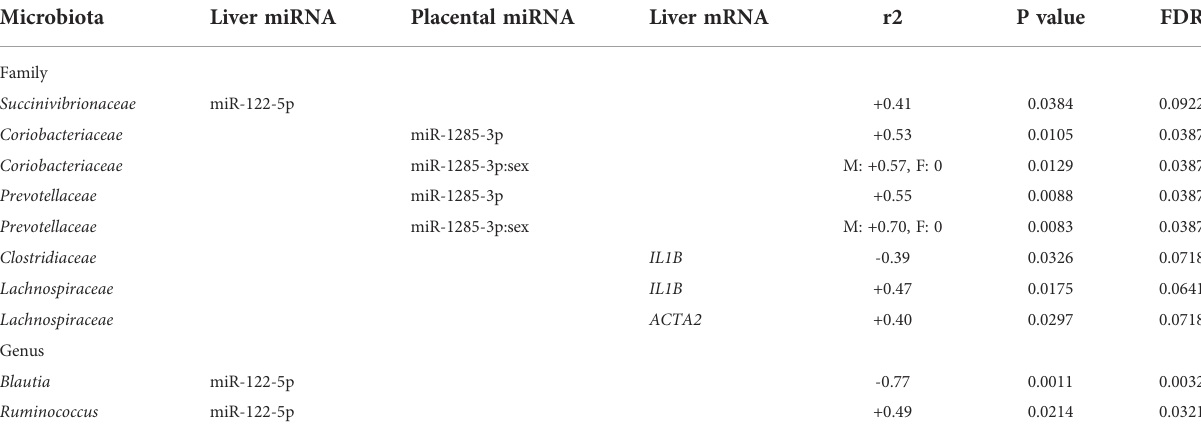
TABLE 5 Associations between maternal microbiota, fetal liver and placental miRNA, and fetal liver mRNA expression levels.